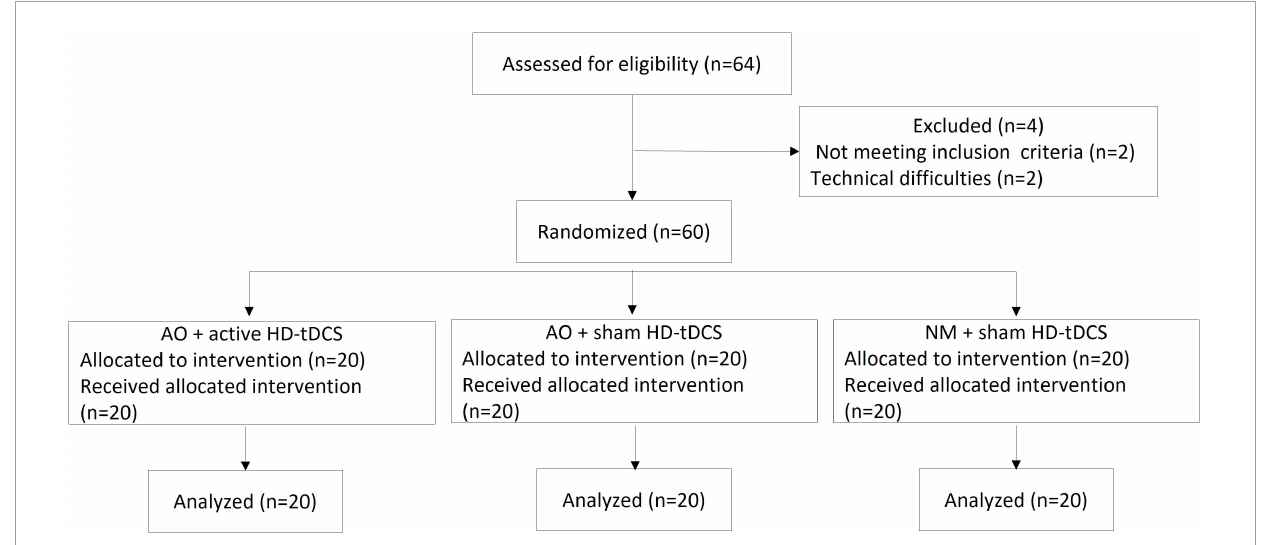
FIGURE4 Trial flowchart. AO, action observation; HD-tDCS, high-definition transcranial direct current stimulation; NM, neutral movie.